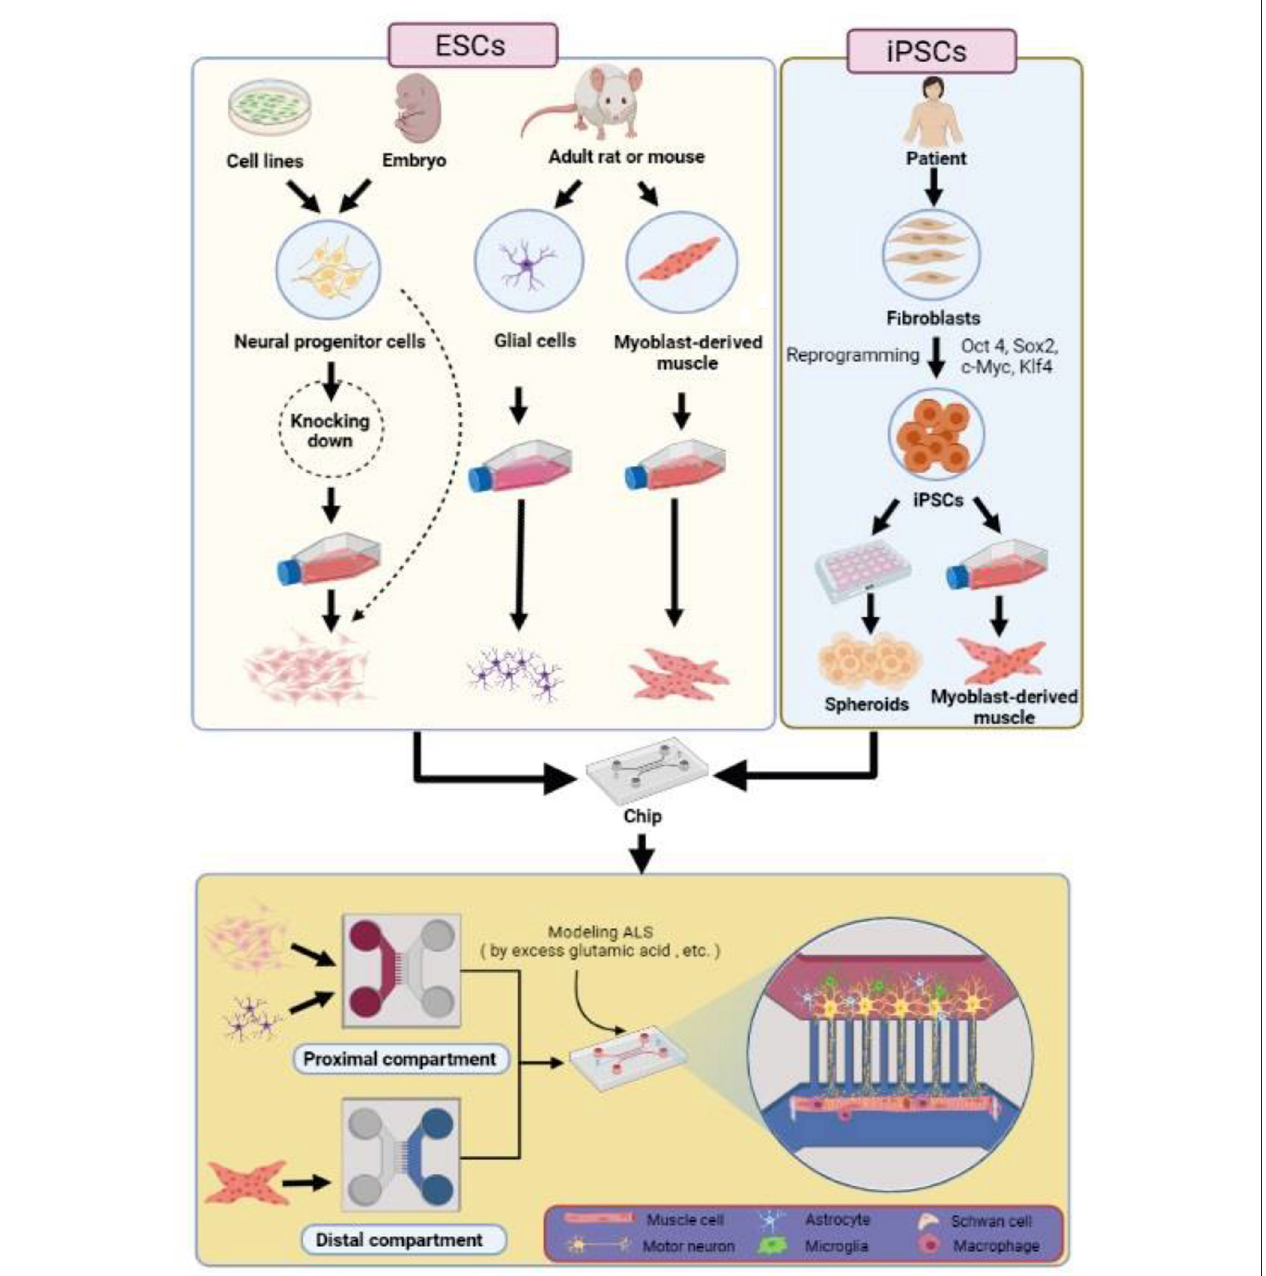
FIGURE 3 | ALS modeling on a chip. To create the ALS model on a chip, two cell sources can be used, which include ESC and the patient’s somatic cells. In the case of ESCs, neural progenitor cells can be obtained from cell lines and mice or rat embryos. Neural progenitor cells can be used directly in the chip or after cell culture. In addition, neural progenitor cells can be combined with optogenetics technology to express light-sensitive channelrhodopsin-2. To obtain muscle and glial cells, adult mice can be applied. Both Muscle and glia cells are used in the chip after culturing. In the case of using iPSCs, somatic cells must be forced to express exogenous transcription factors (Oct4, Sox2, Klf4, and c-Myc) through the reprogramming process. iPSCs can form different types of human cells, such as skeletal muscle myoblasts and NSCs. Skeletal muscle myoblasts create mature skeletal muscle cells. NSCs create nervous system cells. To create an ALS model, skeletal myoblast cells are first embedded with a collagen gel into the distal compartment of the chip. The muscle-engineered cells begin to grow and differentiate while they hover between two pillars. NSCs are then embedded in the proximal chamber of the chip along with the collagen gel. NSCs express a series of factors that form motor neurons and elongate axons toward muscle cells. In addition to astrocytes, cells such as microglia, Schwann cells, and macrophages should be included in the chip. As the cells mature, the structure of the NMJ completes. Some techniques such as adding high concentrations of glutamic acid to the culture medium are used to demonstrate the NMJ dysfunctionality to model the ALS disease. Techniques such as time-lapse microscopy, calcium imaging, pillar displacement, partied image velocimetry, image subtraction video recording, mitochondrial dyes, axon-seq, FISH, and immunocytochemistry applied to evaluate the NMJ model within microfluidic chips (75, 90, 112, 113). ESCs, Embryonic stem cells; FISH, fluorescence in situ hybridization; GFAP, glial fibrillary acidic protein; iPSCs, induced pluripotent stem cells; NMJ, Neuromuscular junction; NSCs, Neural stem cells; PDMS,